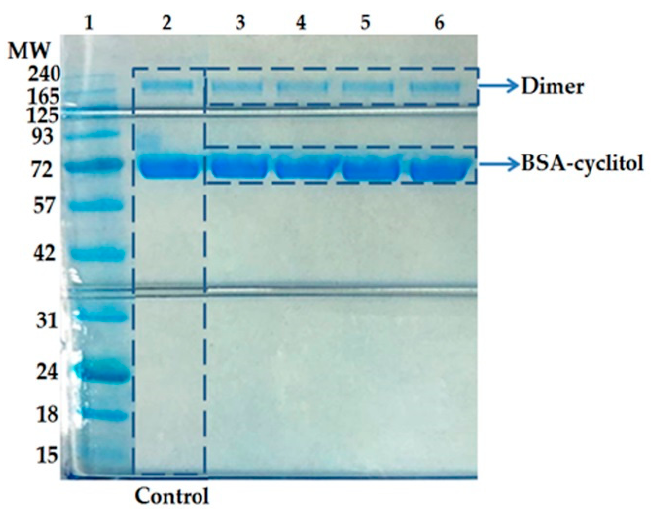
Figure 1. SDS-PAGE electropherogram: 1, BlueStar Plus Prestained Protein Marker; 2, BSA (control); 3, BSA/D-sorbitol; 4, BSA/adonitol; 5, BSA/shikimic acid; 6, BSA/D-( – )-quinic